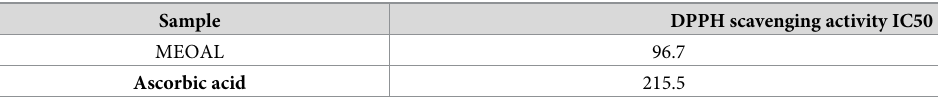
Table 3. Antioxidant activity of